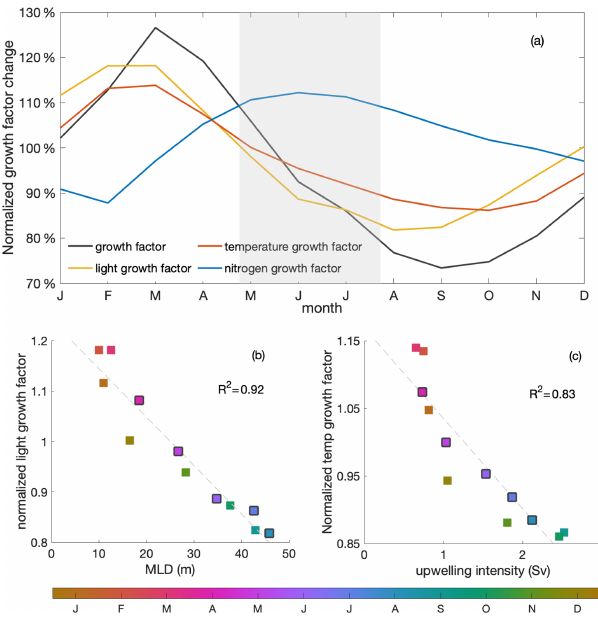
Figure 5. (a) Seasonal cycle of phytoplankton source and sink pro- cesses as well as phytoplankton biomass change ( (cid:49)B multiplied by a factor of 10; solid line); bar plots of the integrated change over the decline phase due to (b) biological fluxes and (c) physical fluxes averaged over the focus region (PP: primary production; GRAZ: consumptive mortality; MORT: natural mortality; EXU: exudation; SINK: sinking; MIX: mixing; ADV: advection). A positive or neg- ative sign of the bars here designates fluxes promoting and oppos- ing an increase in MLD-integrated phytoplankton biomass, respec- tively. The magnitude (including the sign) of the integrated change is given as numbers above and below the bars.